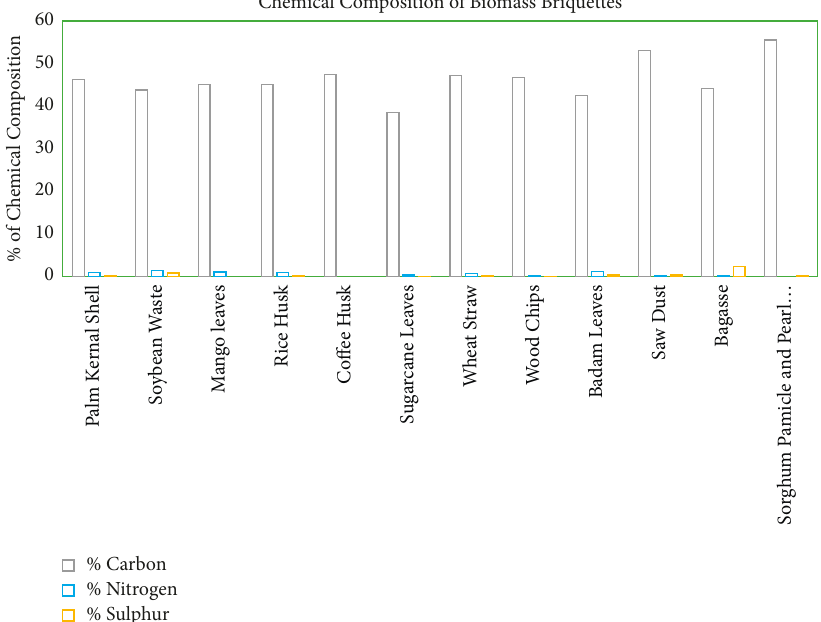
Figure 2: Chemical composition of biomass